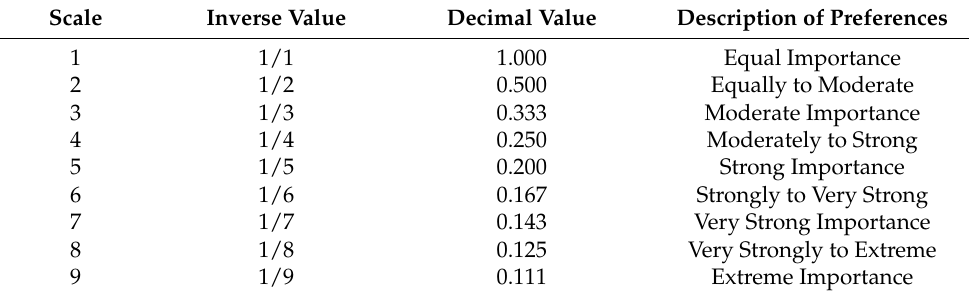
Table 2. Thomas Saaty 1–9 Scale for AHP Pairwise